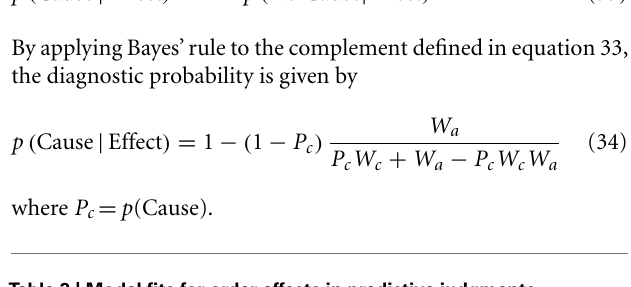
Table 3 | Model fits for order effects in predictive